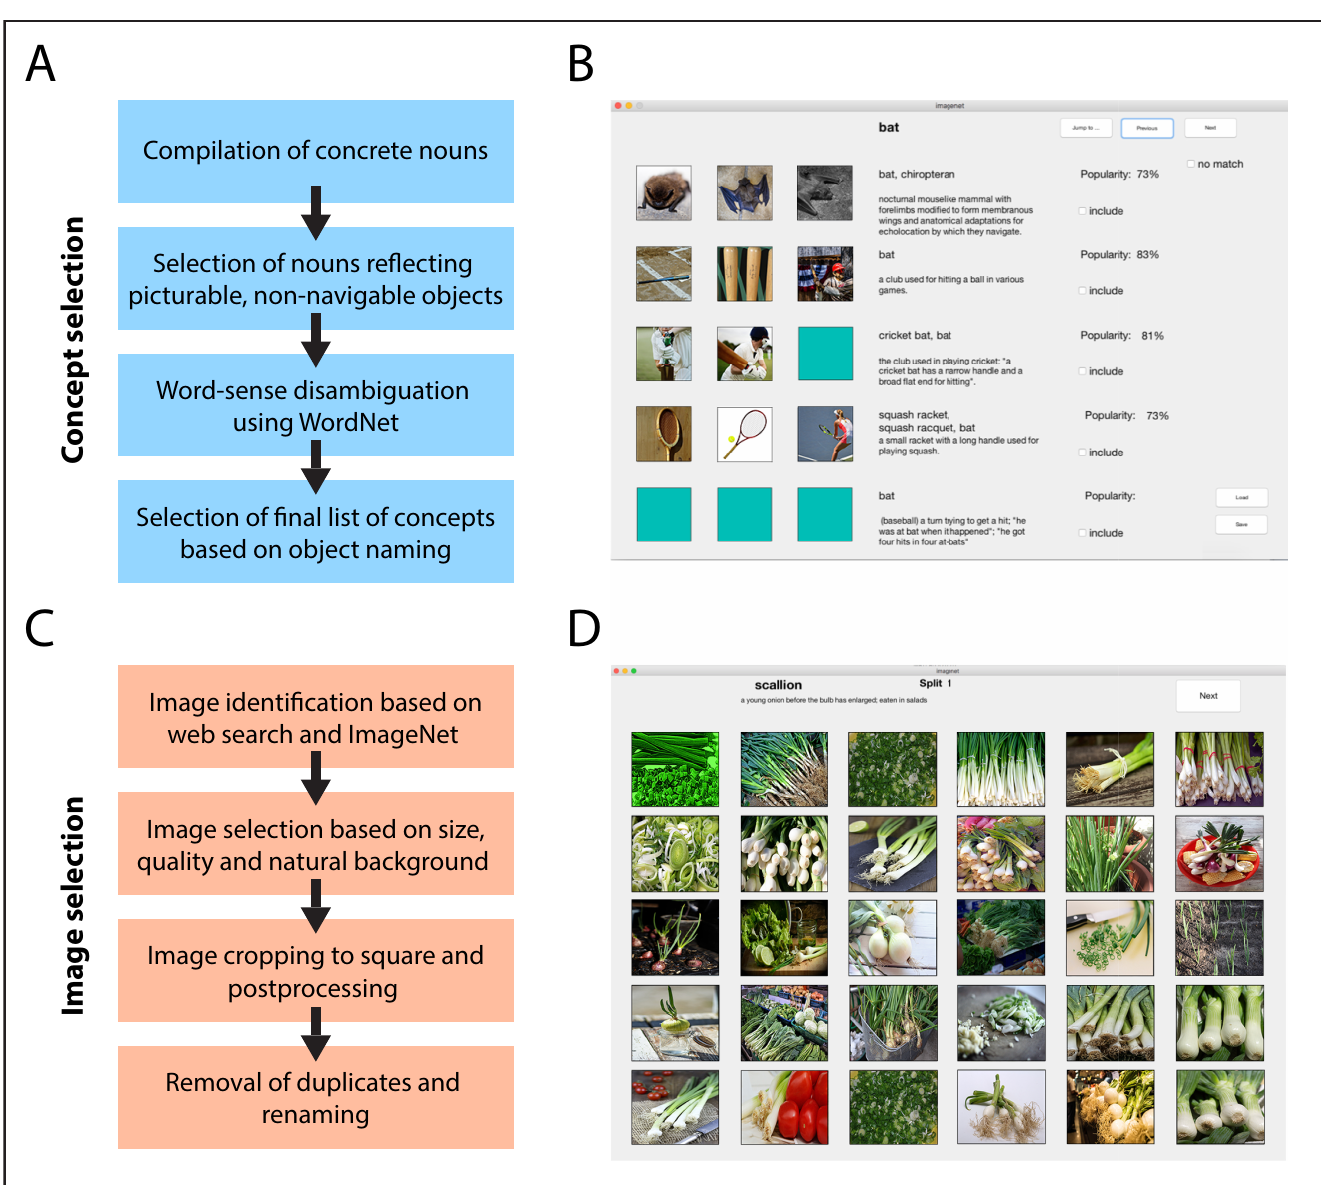
Fig 1. Concept and image selection procedure and graphical user interfaces (GUIs) used for concept and image selection. (A) Procedure for selection of 1,854 concepts in the THINGS database. (B) GUI used for word-sense disambiguation based on WordNet senses (synsets) and example images from ImageNet. (C) Procedure for selection of 26,107 object images in the THINGS database. Original images replaced due to the journal’s copyright policy. (D) GUI used for initial manual selection of candidate images with sufficient quality. Original images replaced due to the journal’s copyright